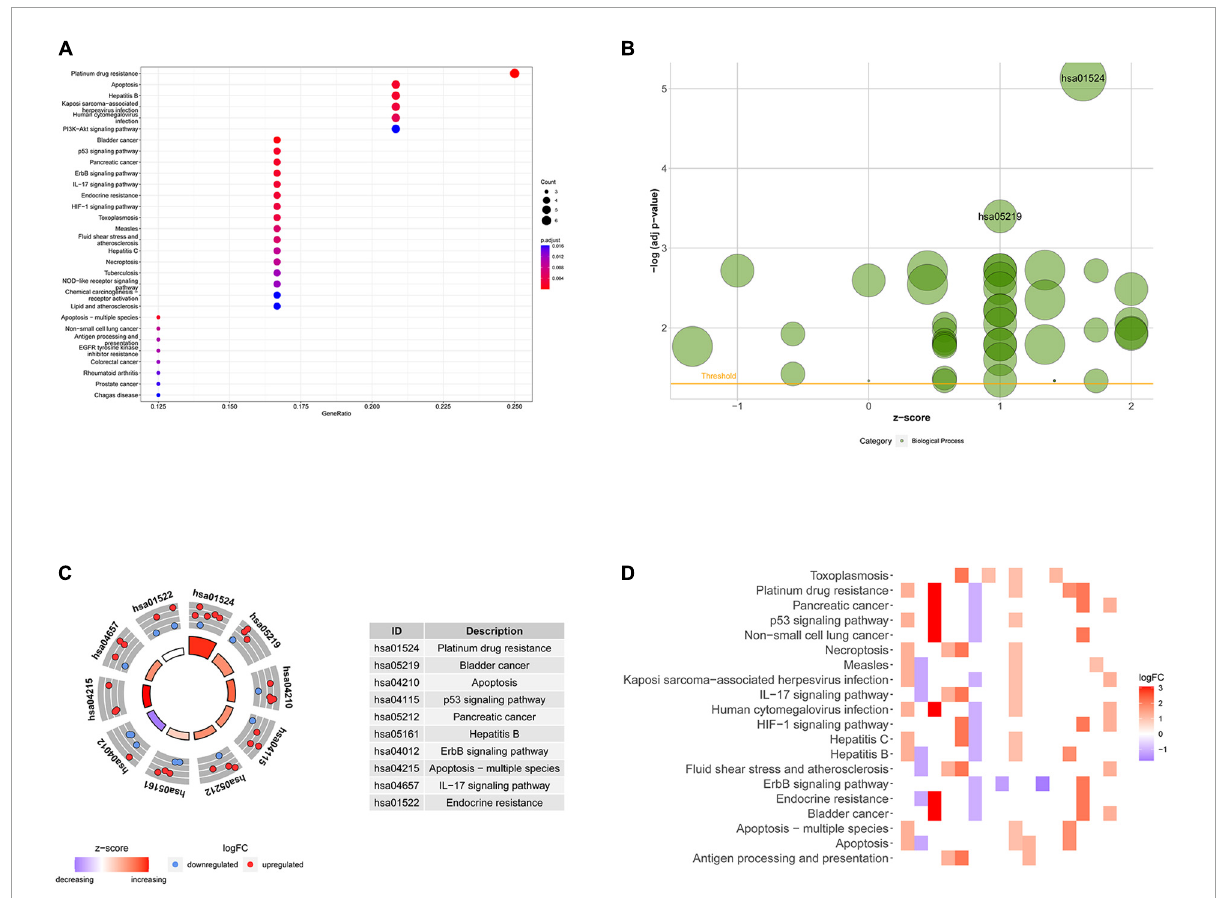
FIGURE2 Kyoto Encyclopedia of Genes and Genomes (KEGG) analysis of differentially expressed necroptosis-related genes (NRGs). (A) Bubble chart of the top 30 enrichment pathways; (B) bubble diagram of enriched KEGG pathways; (C) circle diagram of enriched KEGG pathways; (D) heatmap of enrichment analysis. The color of each block represents the | log2 (FC)|